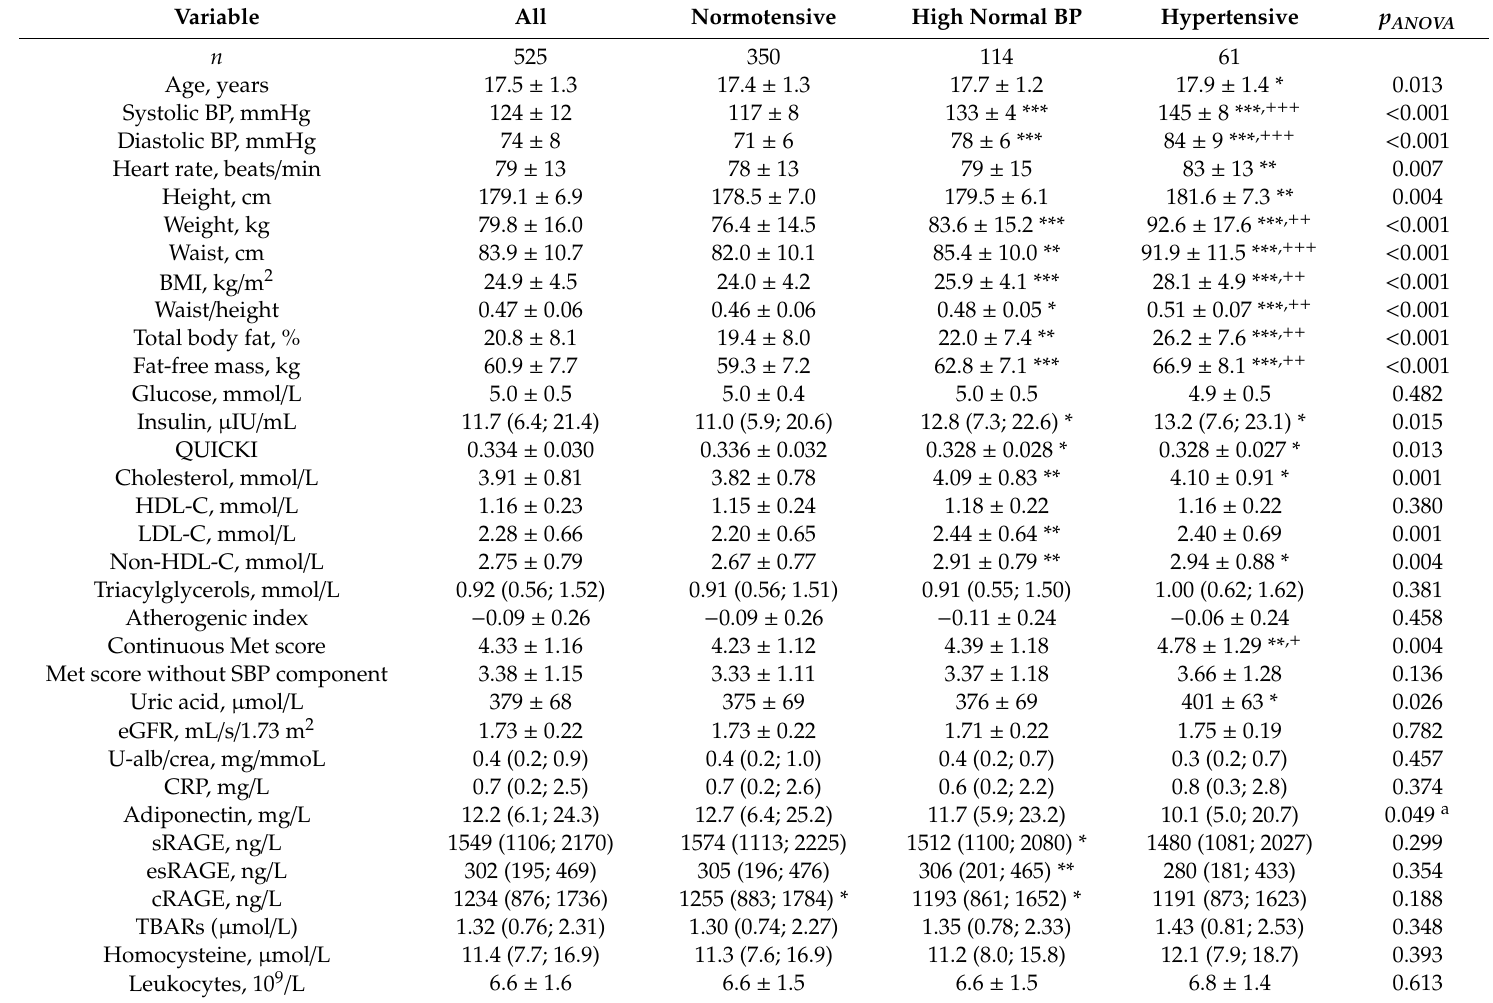
Table 4. Characteristics of males presenting cardiometabolic risk